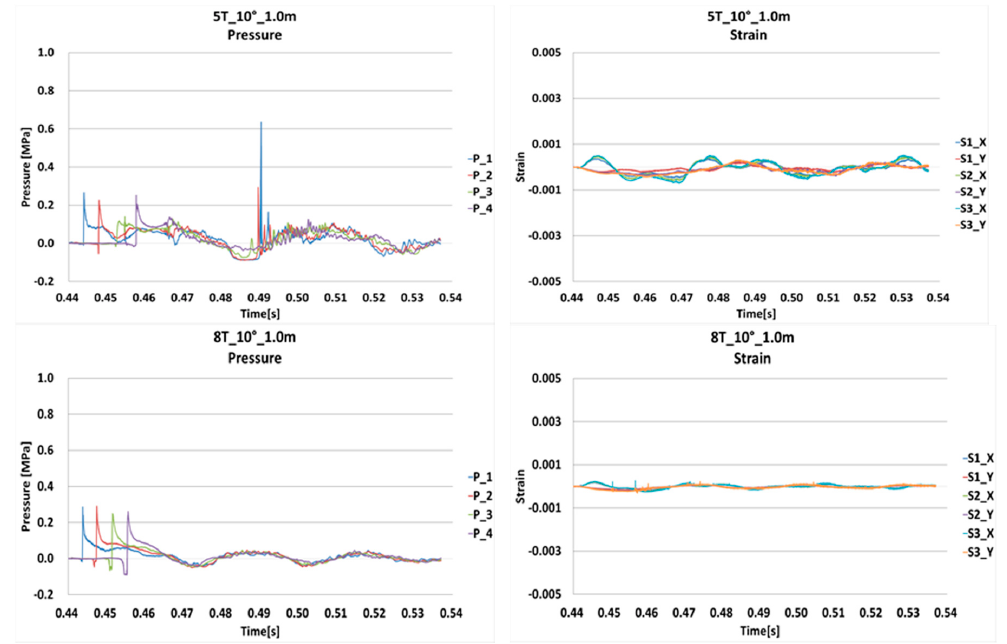
Figure 9. History of pressure and strain in the model with deadrise angle of 10° (Drop height: 1.0 m).